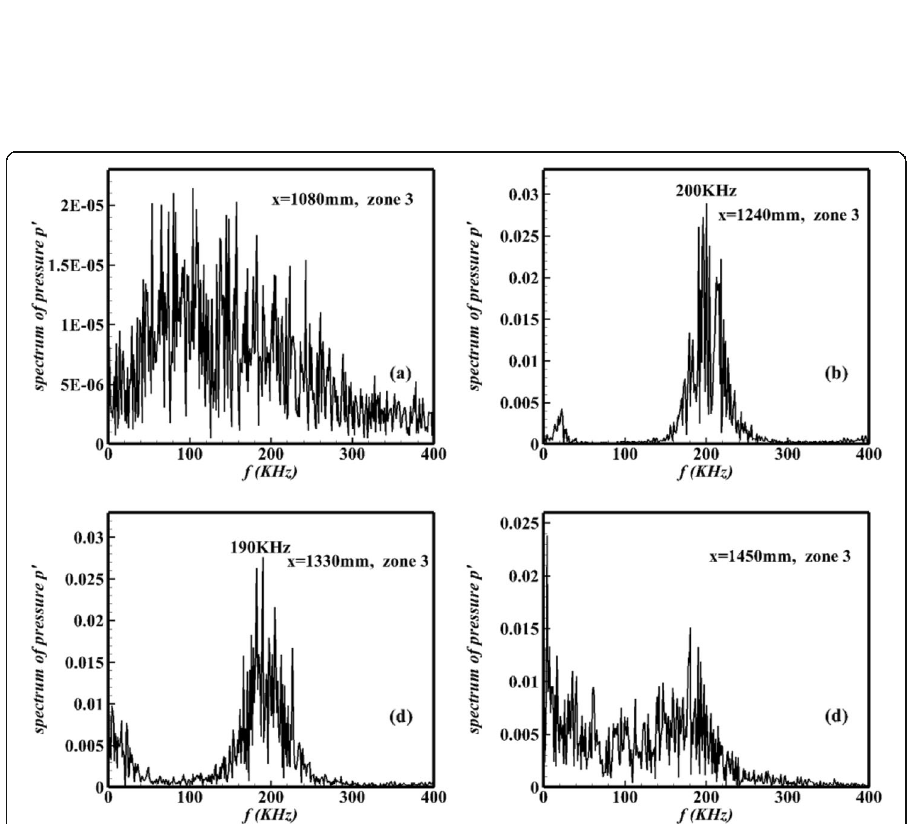
Fig. 19 Spectra of pressure fluctuations of zone 3; ( a ) x = 1080 mm, ( b ) x = 1240 mm, ( c ) x = 1330 mm, ( d ) x = 1450